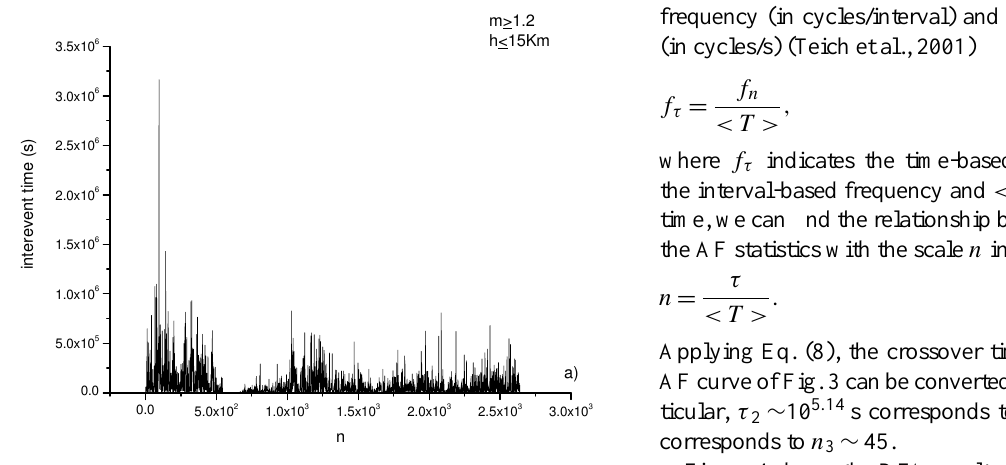
Fig. 3. Interevent time series of the sequence of the seismic events with magnitude m ≥ 1 . 2 and depth h ≤ 15km.